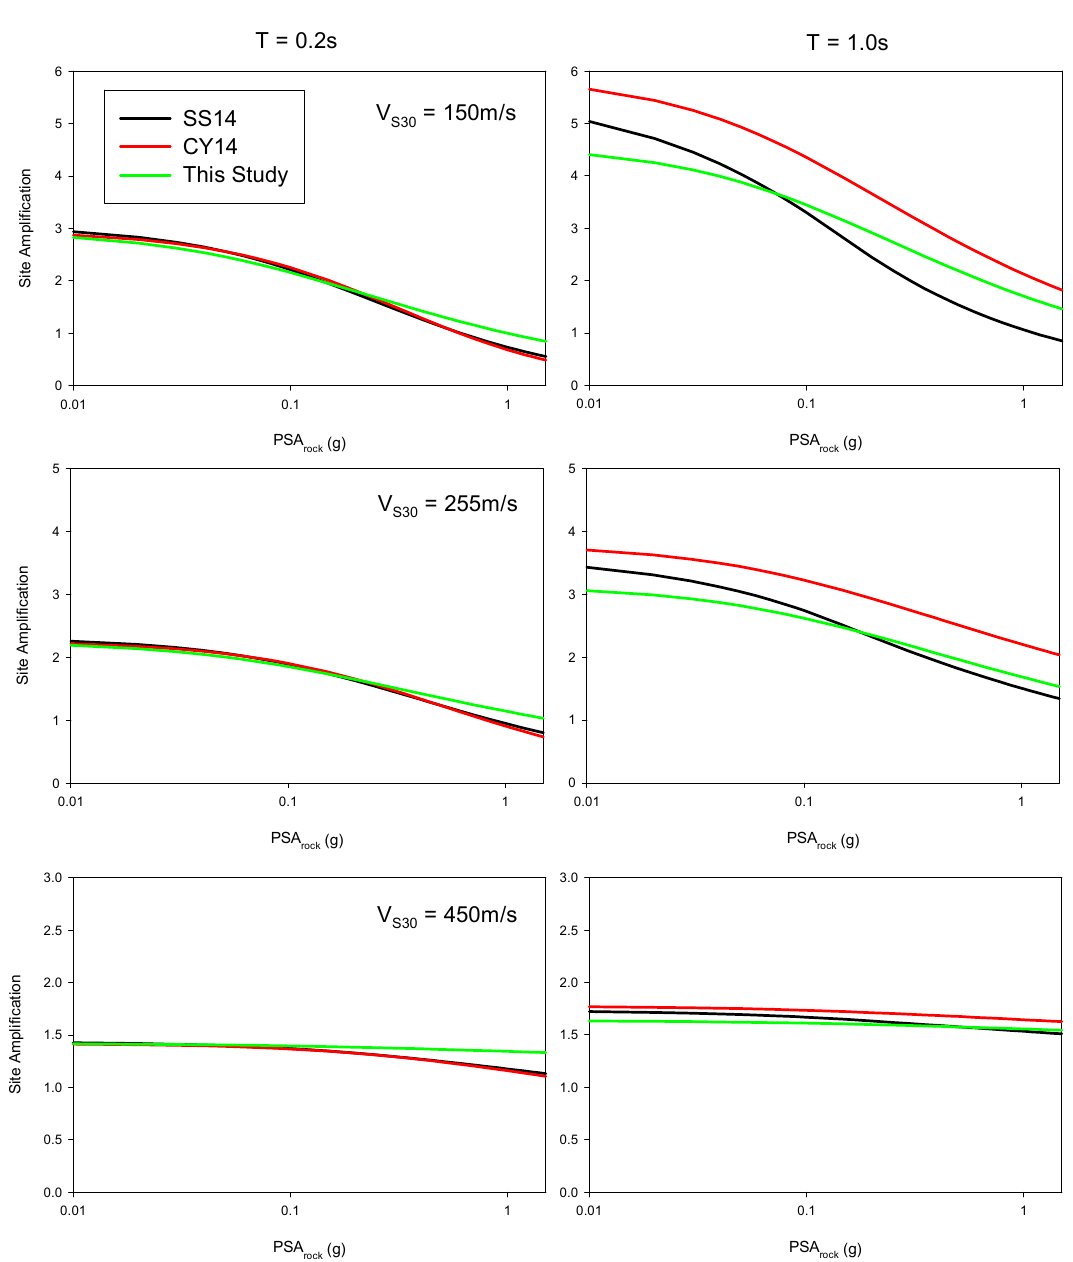
SS14 site model. For the V S 30 -scaling of the proposed model, SS14 and CY14 site models were similar at stiff site condition. However, as V S 30 decreased the differences became more prominent. The 1 s amplification was matched with the SS14 site model, with both models producing lower amplification when compared to the CY14 site model.